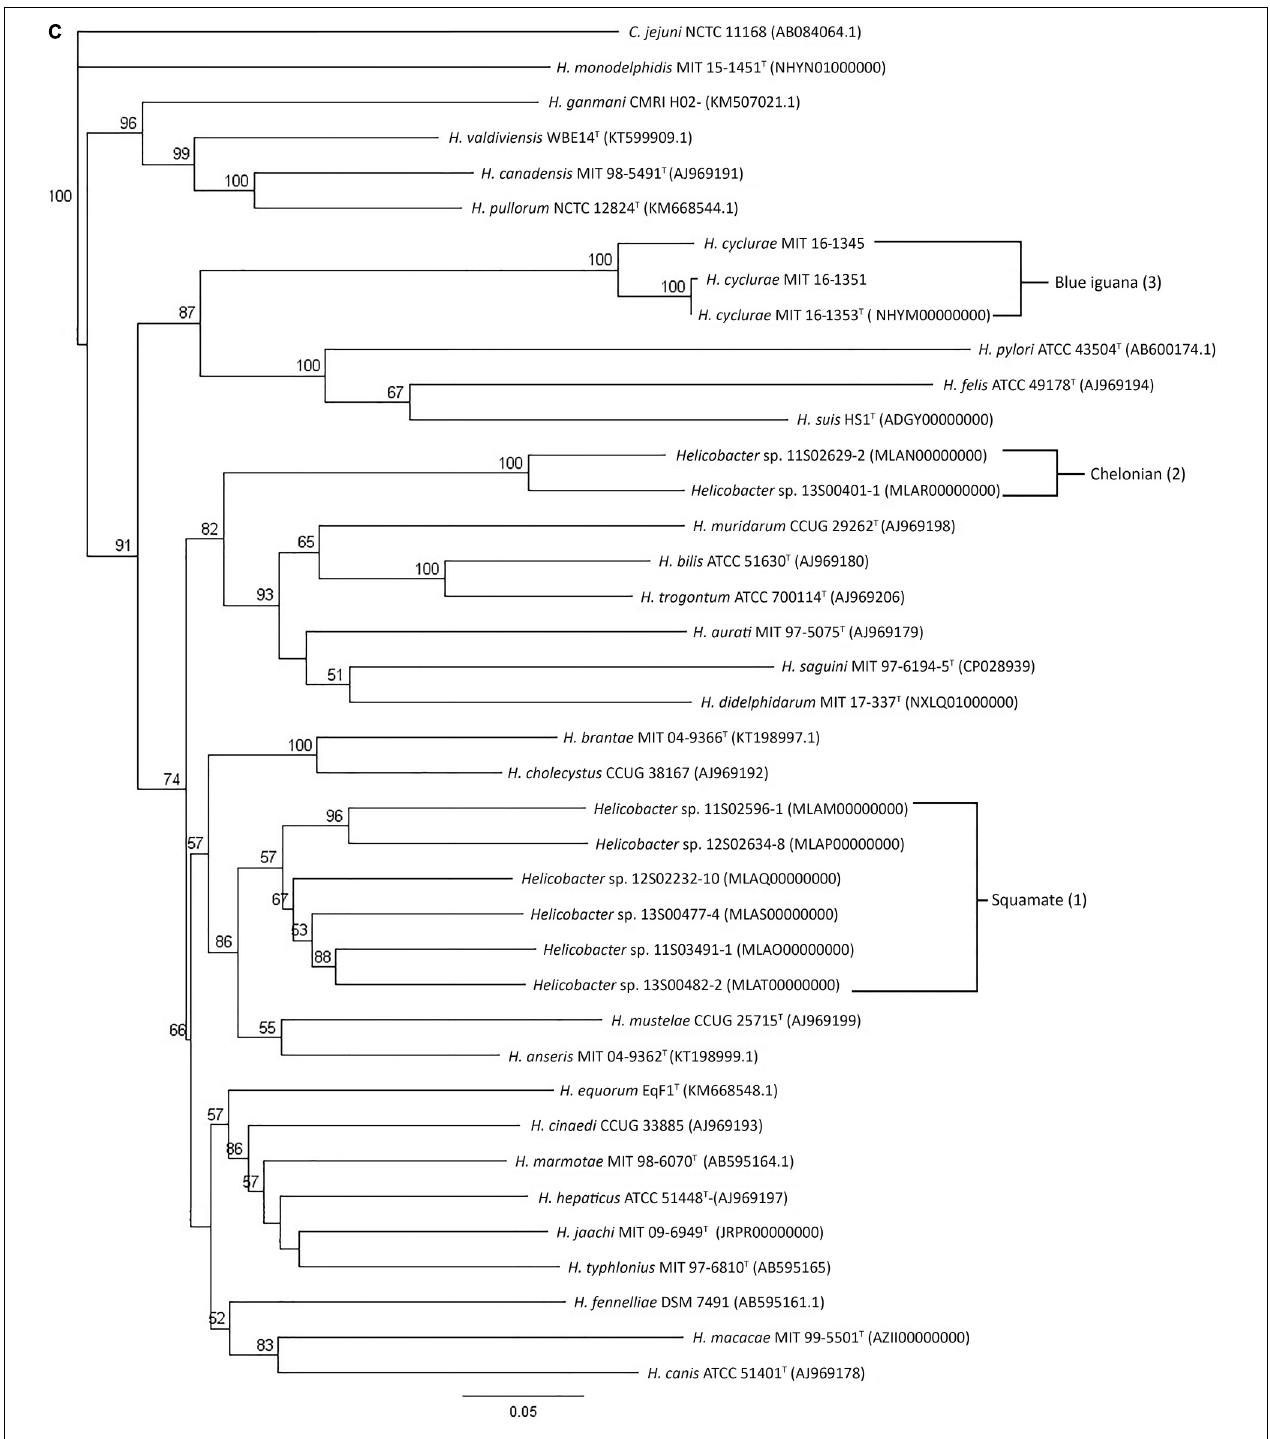
FIGURE 1 | Phylogenetic analysis of 16S rRNA, (A) hsp 60, (B) and gyr B (C) gene sequences. Neighbor-joining trees were based on the comparison of genes from different Helicobacter species. C. jejuni is used as an outgroup. Bootstrap values ( > 50%) based on 1,000 replications are indicated. GenBank accession numbers (in parentheses) are provided for each strain. The scale bar indicates branch length as number of substitutions per nucleotide. (1) Reptiles in the order of Chelonian: turtles and tortoises. (2) Reptiles in the order of Squamata: snakes and lizards. (3) Blue iguana: belongs to the order of Squamata.